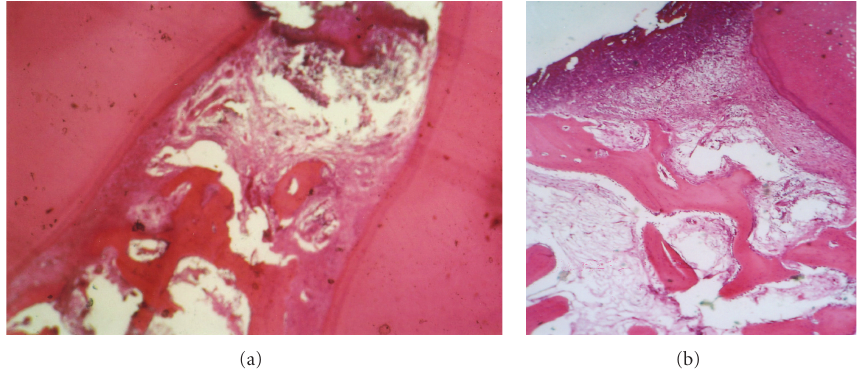
Figure 6: Periodontal tissue response in the dog following a 3- (a) or 8- (b) weeks application of TGF- β 1. Note the severity of inflammatory cell infiltration and the newly deposited cementum (magnification ×